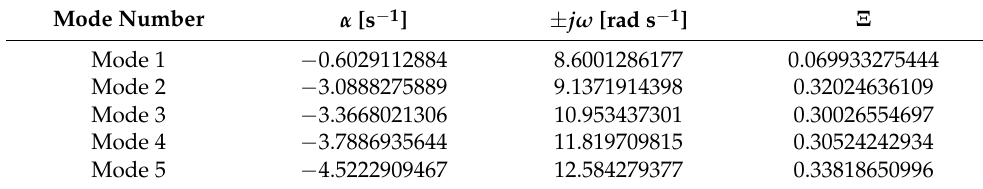
Table 1. Local oscillatory modes for the analyzed system without the PSS implementation.